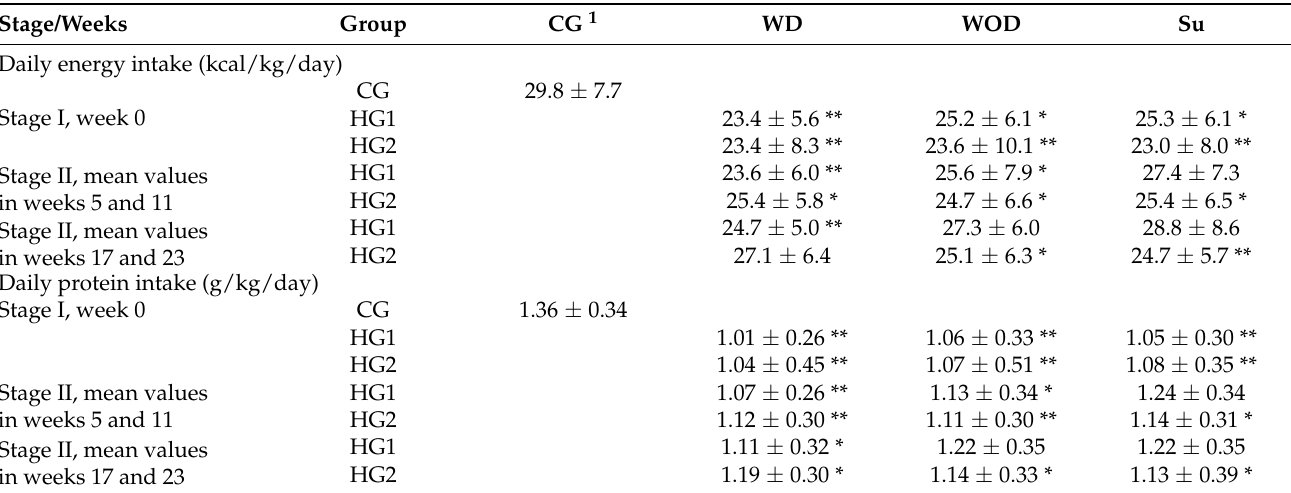
Table 3. Daily energy (kcal/kg/day) and protein (g/kg/day) intake in the studied groups of partici- pants (means ±